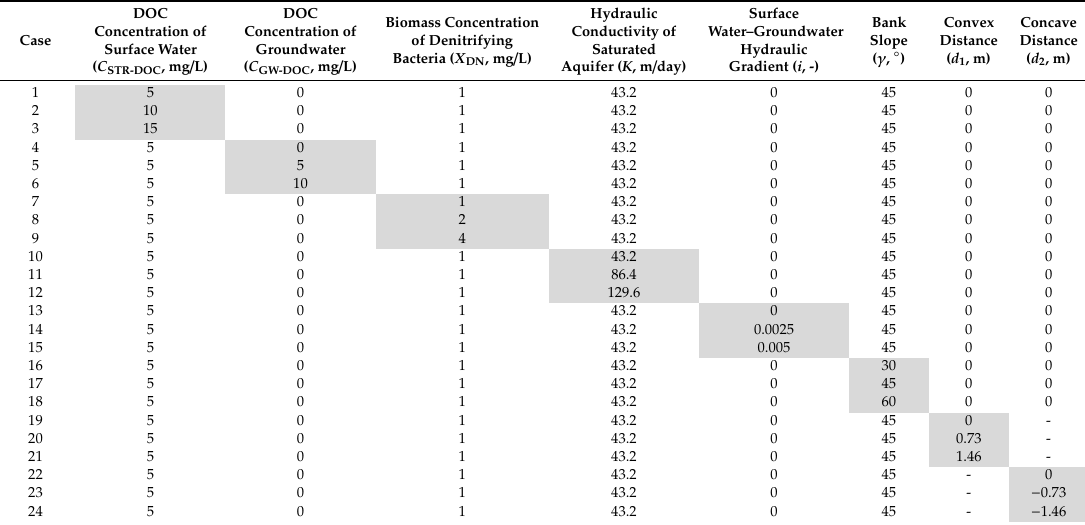
Table 2. The numerical test